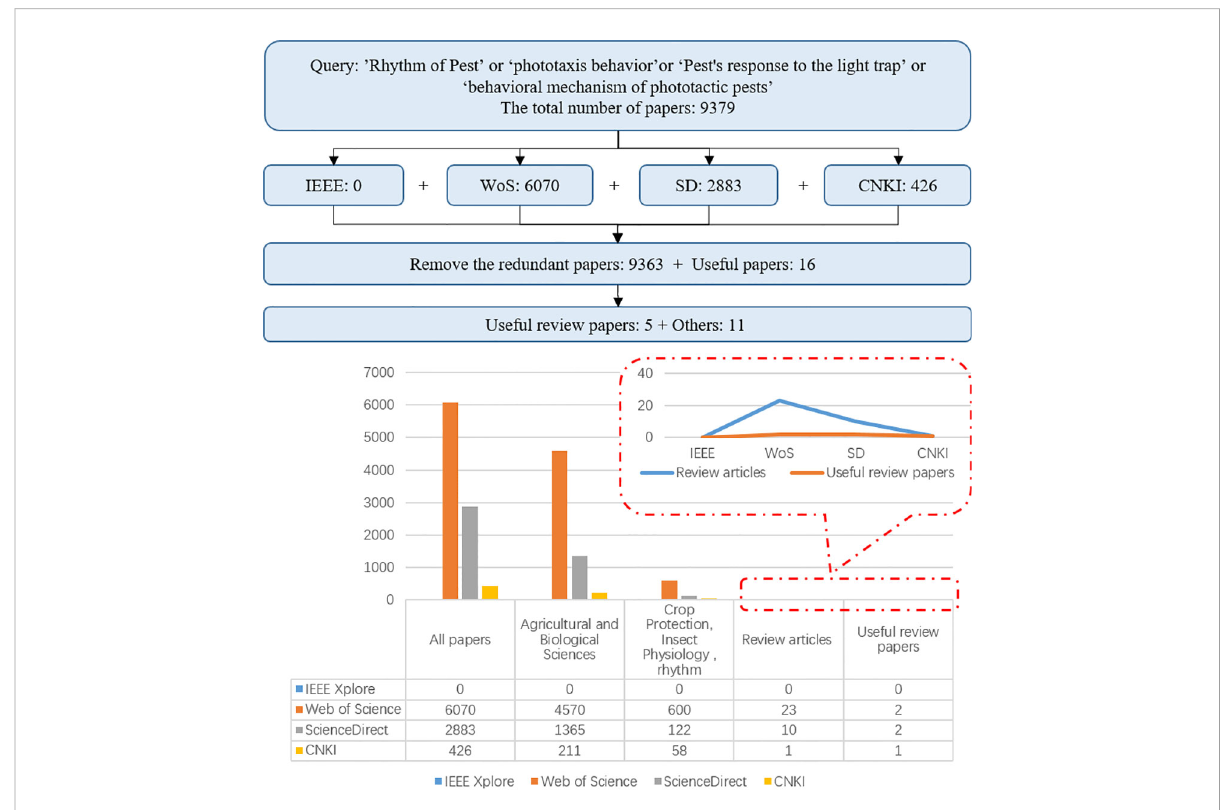
FIGURE 1 The number of articles among the corresponding